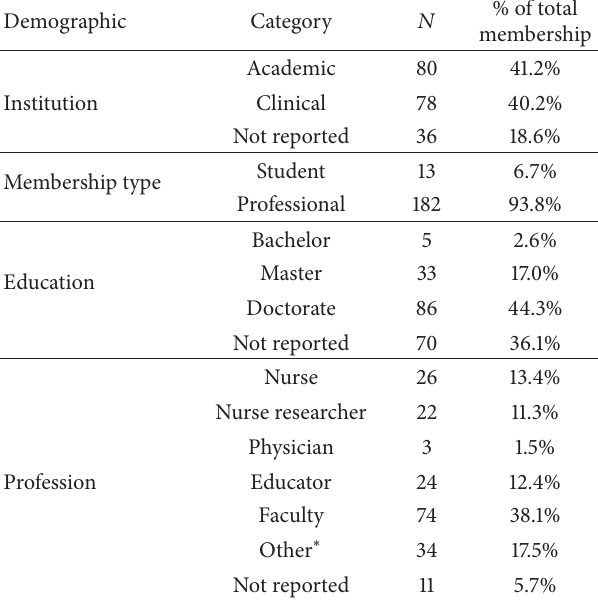
Table 1: Demographic breakdown of ISRN membership (total 𝑁 = 194